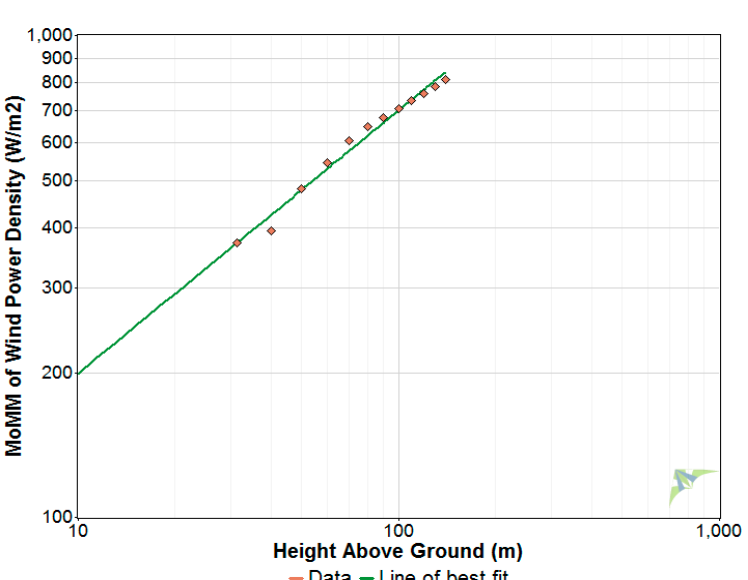
Figure 9. Mean of Monthly Means of WPD vs. height.